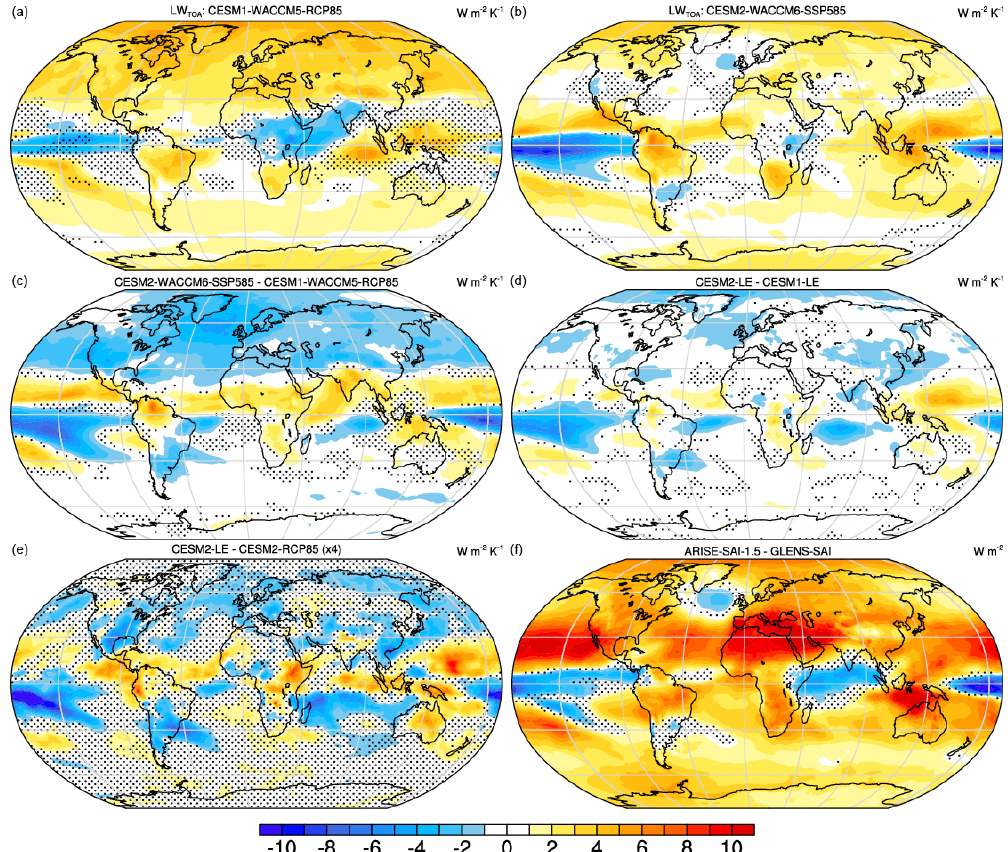
Figure A2. Normalized response in net outgoing top-of-atmosphere longwave flux (LW TOA ) per degree global warming estimated from the change between 2020–2039 and 2050–2069 for unmitigated (a) CESM1-WACCM5-RCP85 and (b) CESM2-WACCM6-SSP585 simulations, and (c) their difference ( a minus b ). Also shown is (d) the analogous difference for CESM1-LE and CESM2-LE and (e) CESM2-RCP85 and CESM2-LE (scaled by 4). The difference between the geoengineered climate states in ARISE-SAI-1.5 and GLENS-SAI is shown in panel (f) . Units for all panels are Wm − 2 K − 1 , except in panel (f) where units are Wm − 2 , and stippled regions indicate differences that are less than twice the ensemble standard